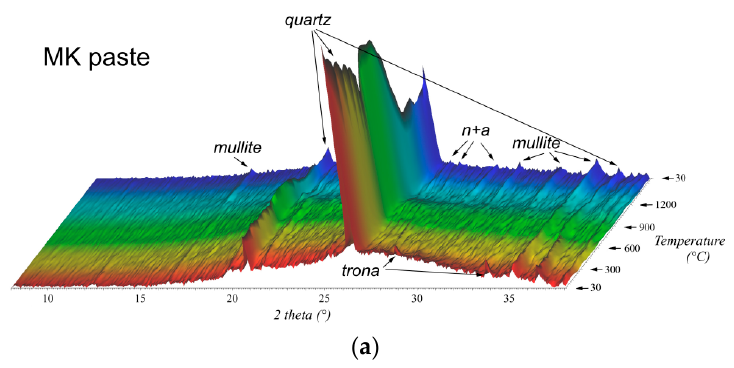
Figure 10. Cont . Figure 10. Cont .